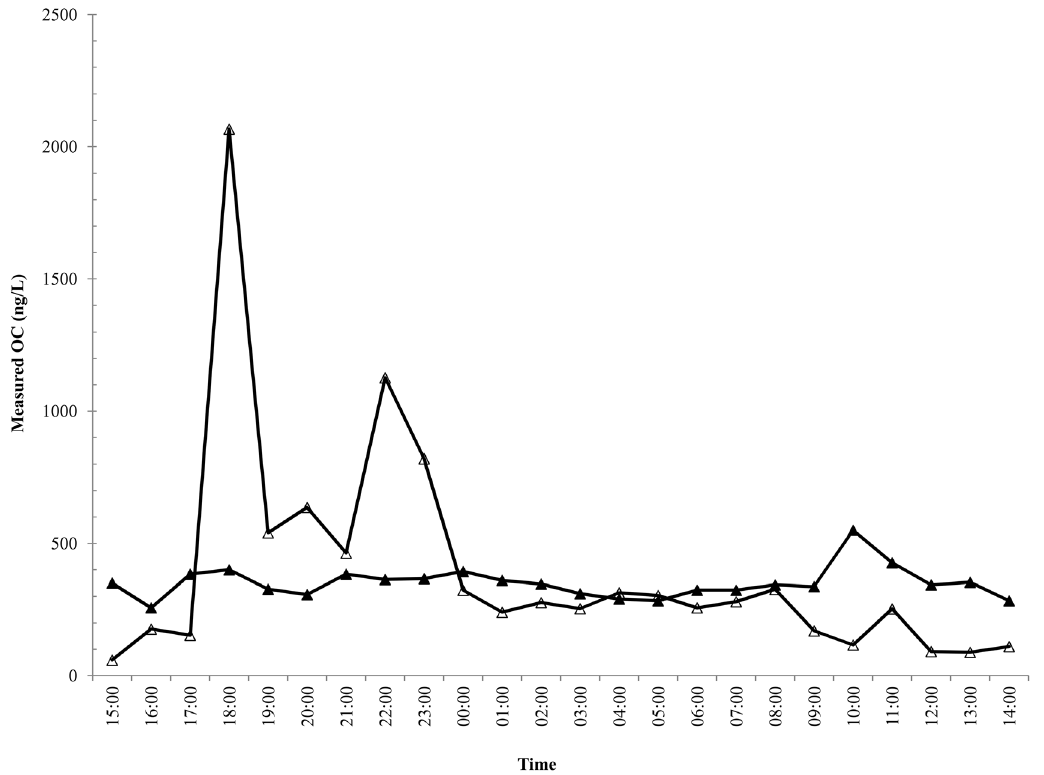
Figure 2. Oseltamivir Carboxylate Concentration in Waste Water. Hourly time-proportional influent concentration of OC (ng/L) in Oxford WWTP (shaded) and Benson WWTP (open).